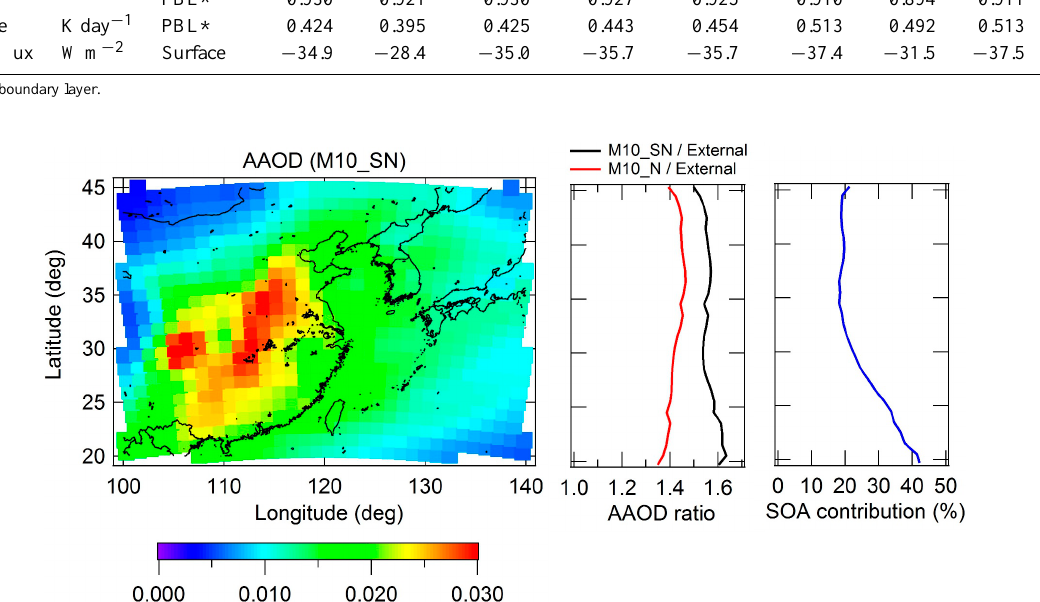
Figure 8. (a) The period- and domain-averaged column AAOD in the M10_SN simulation. (b) The latitudinal dependence of mean AAOD values in the M10_SN (black) and M10_N (red) simulations normalized by the column AAOD calculated by assuming externally mixed BC particles (External). In the External calculation, all of the internally mixed BC particles are separated into BC (externally mixed) and non-BC (BC-free) particles. (c) The latitudinal dependence of the contribution of SOA processes to the absorption enhancement by coating materials. The contribution is calculated from two column AAOD differences: the fraction of the AAOD difference between the M10_SN and M10_N simulations (M10_SN – M10_N) relative to the AAOD difference between the M10_SN simulation and the external calculation (M10_SN –